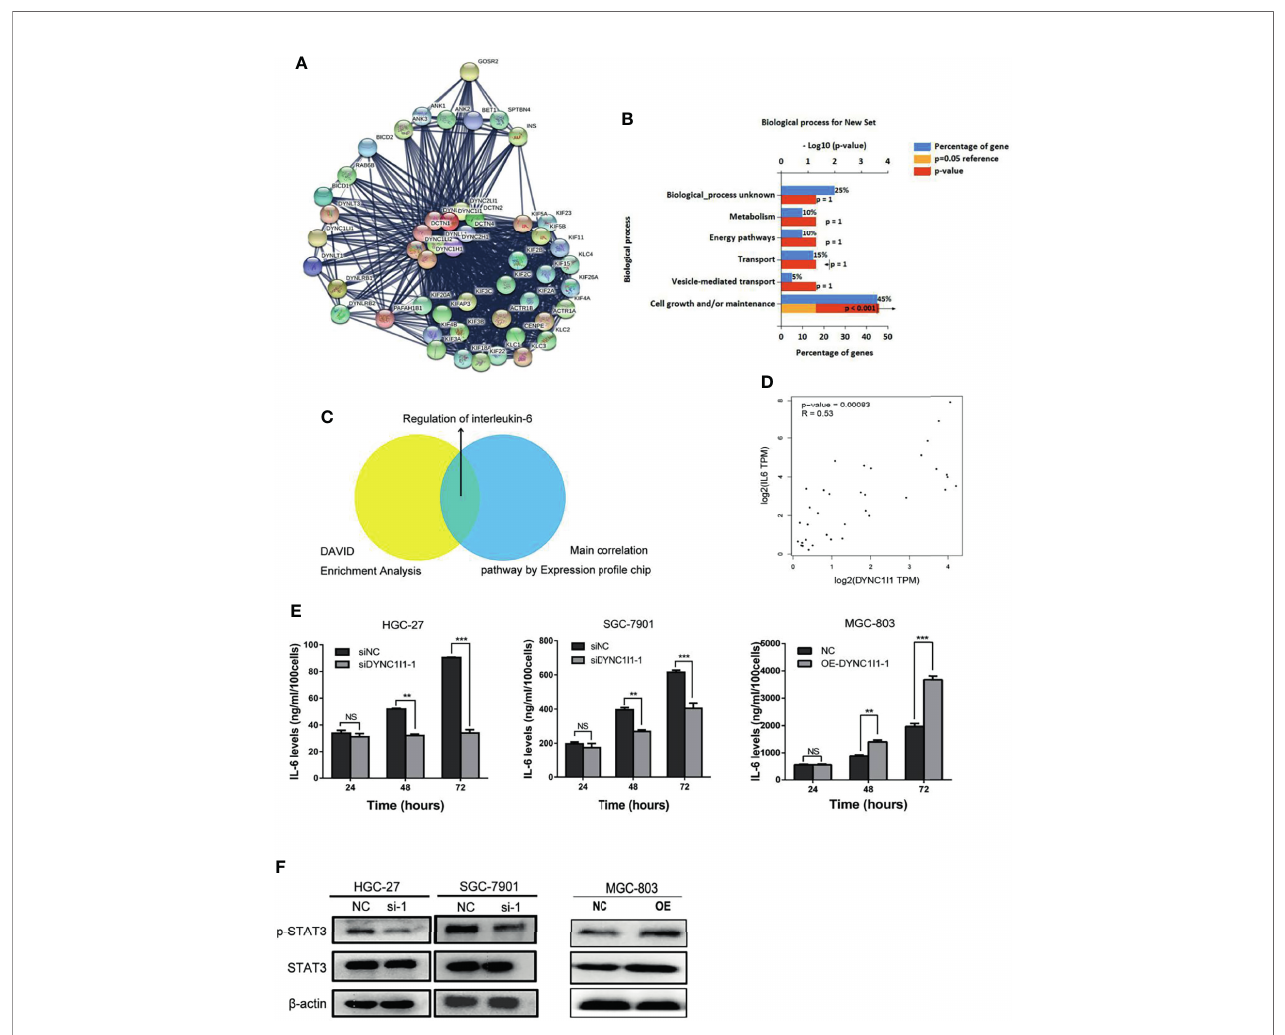
FIGURE 5 | DYNC1I1 may function by regulating the IL-6 pathway. (A) Sting Website enrichment DYNC1I1 related genes and FunRich software enrichment related pathway. (B) FunRich software for Biological Pathway Enrichment Analysis. (C) Expression pro fi le chip shows the main correlation pathway about DYNC1I1. (D) GEPIA website analysis the correlation between DYNC1I1 and IL-6 in gastric cancer. (E) Elisa shows the change of IL-6 expression after knocking down or overexpression DYNC1I1. (F) Western blot indicates the differential levels of STAT3, P-STAT3. b -actin was used as a loading control in Western blot. (** P < 0.01, *** P < 0.001, n = 3, NS, Not Statistically Signi fi cant student t -test, means ± 95%